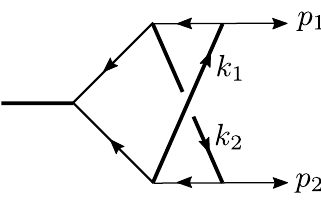
Figure 4 . Triangle with massive